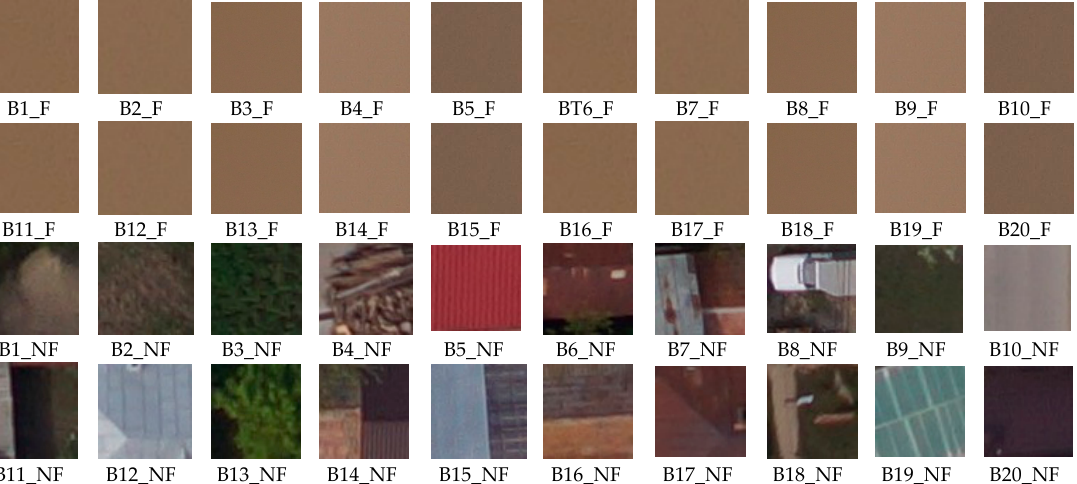
Figure 9. Patches for establish the weight signature (Bi_F as patch with flood and Bj_NF as non flood patch).